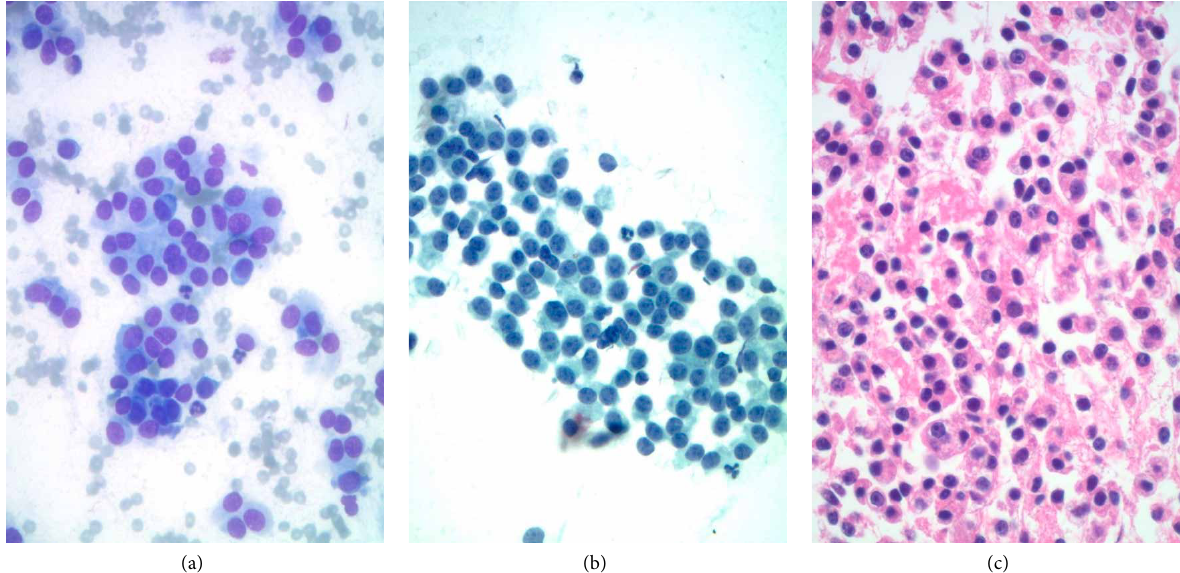
Figure 6: (a) Scattered loosely cohesive collections of epithelioid cells were noted in the direct smear backgrounds (Modified Giemsa stain, 400X). (b) These cells varied in shape from round to oval to plasmacytoid with finely granular chromatin and occasional minute nucleoli (Papanicolaou stain, 400X). (c) These cells appeared similar to the cells between the globules in the cell block but were dyscohesive (Hematoxylin & eosin stain, 400X).